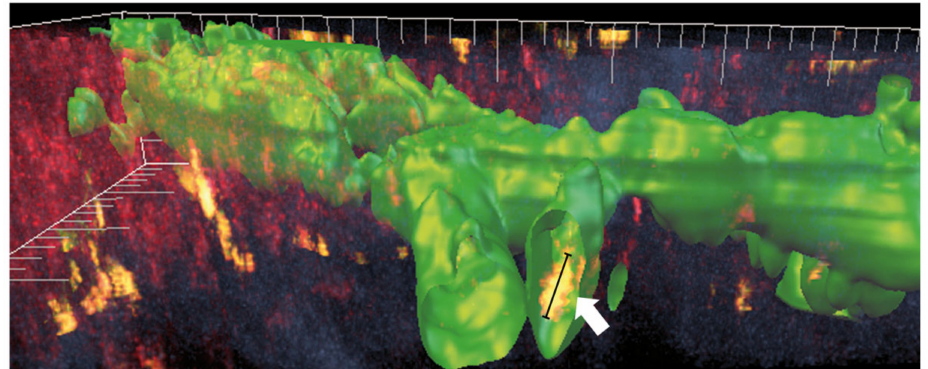
Figure 2. Intravital visualization of lymphatic vessels in the vascularized cornea. By 3D-reconstruction of a 2-photon image stack through the vascularized cornea immune cells (arrow) shown in yellow as an overlay of Alexa488 fluorophore (green) and autofluorescence signal in Alexa488 labeled lymphatic vessels (green), could be observed (Adapted from Steven et al. 2011